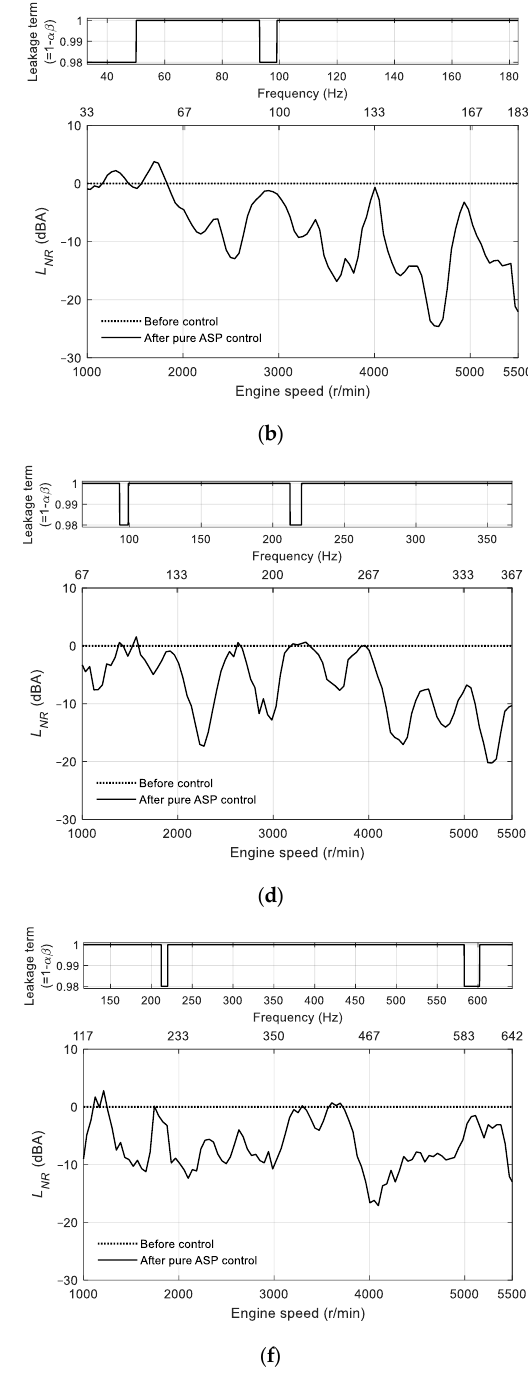
Figure 7. Comparisons of the measured SPL of each order before and after the pure ASP control, and noise reductions. ( a ) SPL of the C2 order. ( b ) Noise reduction of the C2 order. ( c ) SPL of the C4 order. ( d ) Noise reduction of the C4 order. ( e ) SPL of the C8 order. ( f ) Noise reduction of the C8 order.